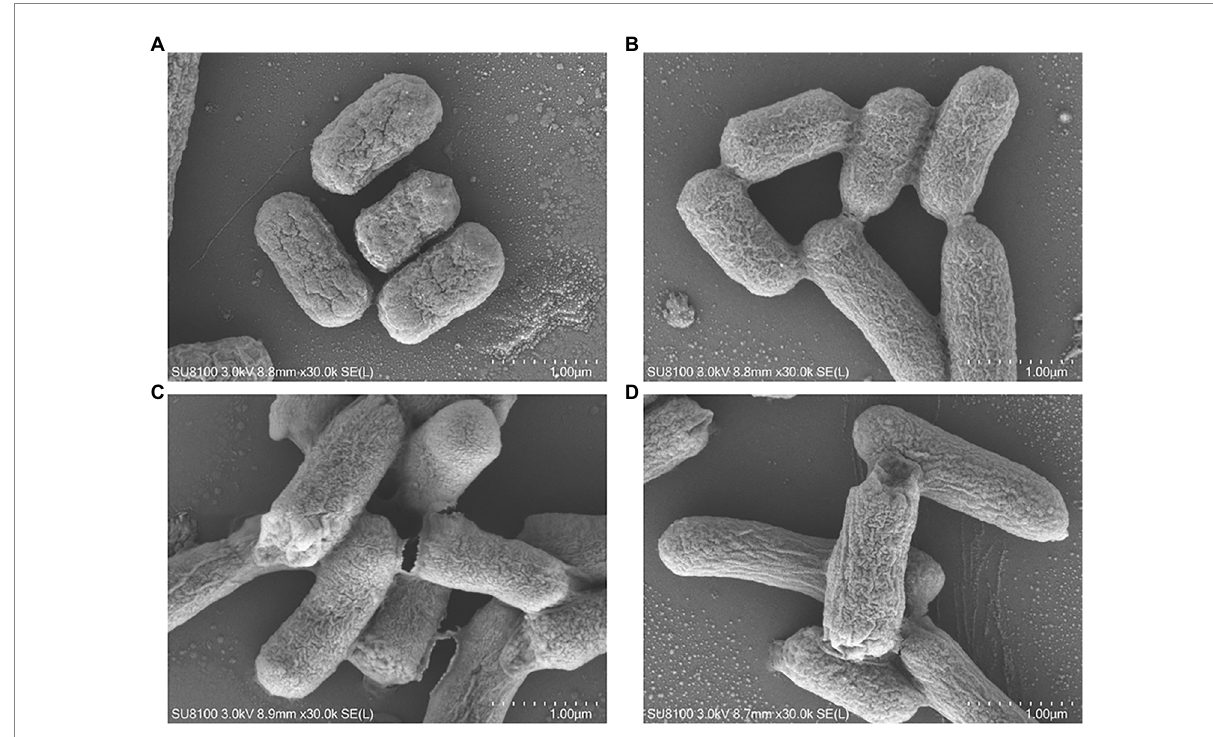
FIGURE 3 SEM images of Escherichia coli K12 and JW5917 strains treated with (C,D) and without (A,B) plantaricin BM-1 (magnification: